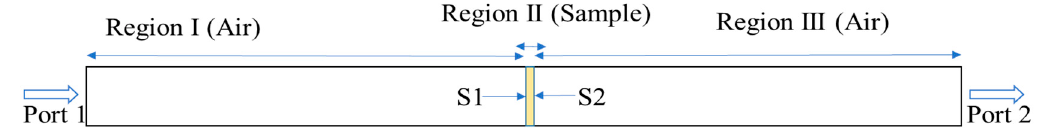
Figure 2. Rectangular waveguide loaded with C-Fe 3 O 4 /PVDF Sample.